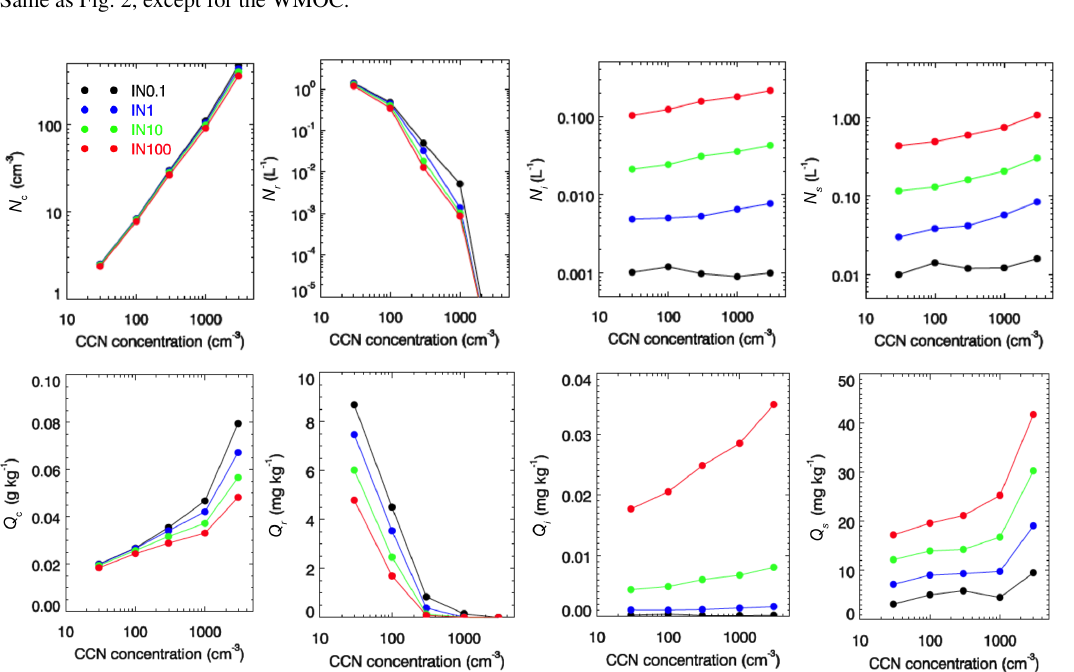
Figure 15. Same as Fig. 3, except for the